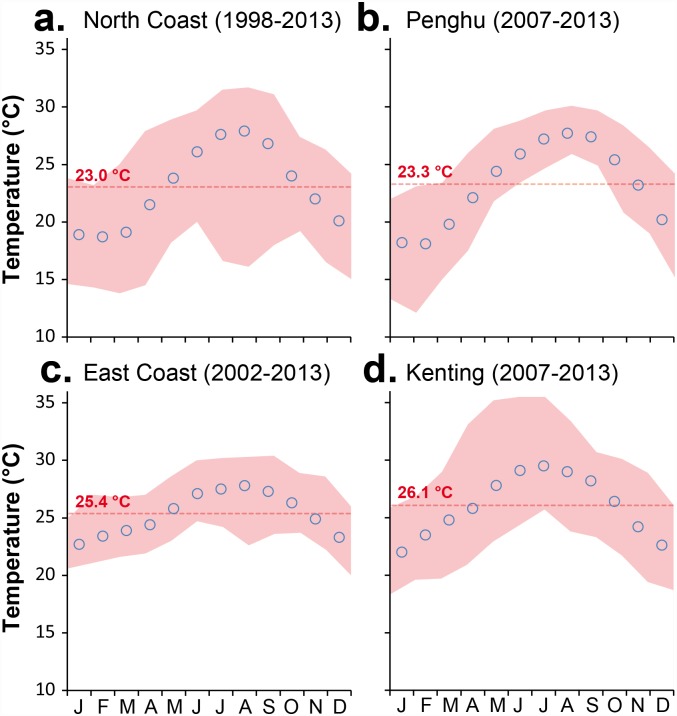
Sea Surface Temperature (SST) around Taiwan.Monthly average sea surface temperatures, annual means (red dashed line), and monthly maxima and minima (red shaded area). (a)Northern Coast (1998–2013). (b). Penghu (2007–2013). (c) Eastern coast (2002–2013). (d) Kenting (2007–2013). Data: Central Weather Bureau, Taiwan (http://www.cwb.gov.tw/).